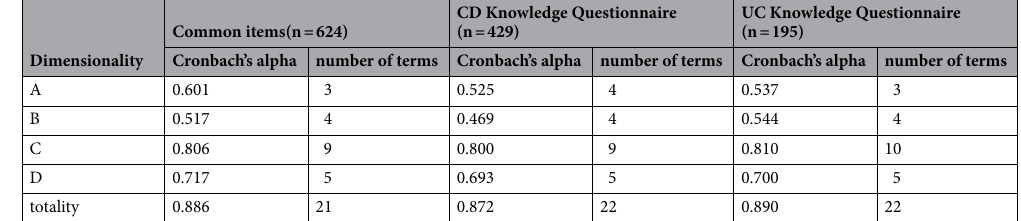
Table 1. Internal consistency of IBD knowledge questionnaire. A: pathology and risk factors, B: diet and nutrition, C: therapy, D: disease surveillance and special